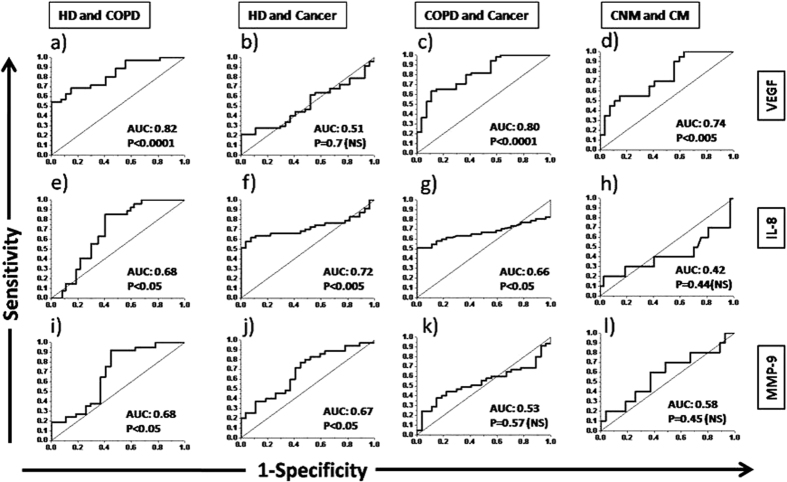
ROC curves of different analytes between various groups.Abbreviations are same as Fig. 1. NS: Non-significant.